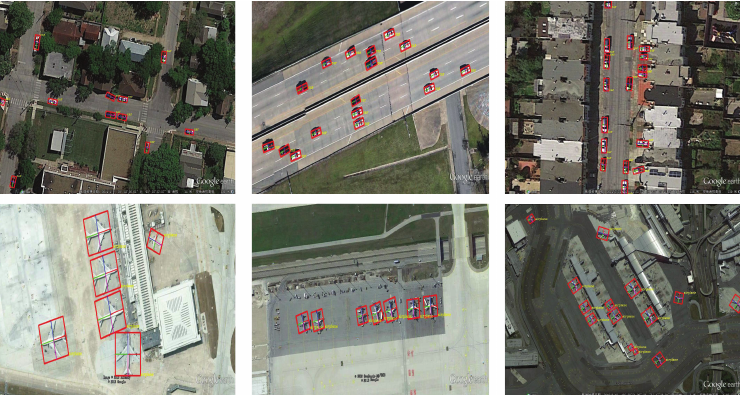
Figure 7. Detection results of the teacher network on the HRSC2016 dataset.